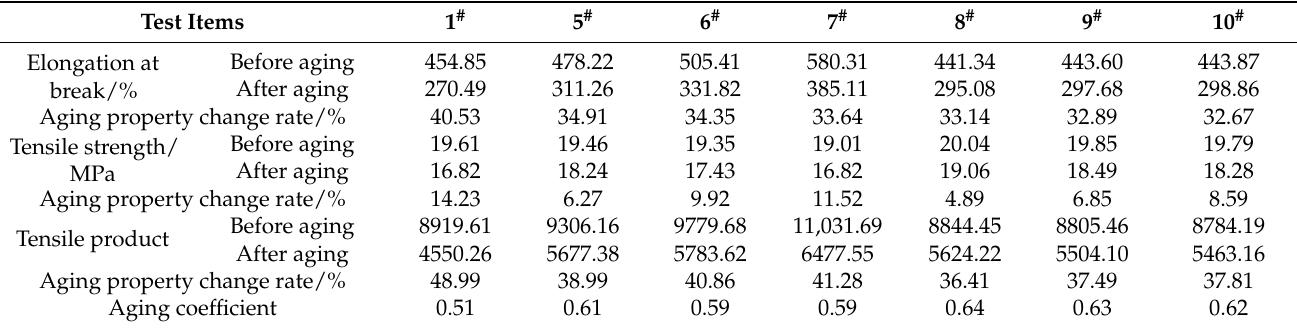
Table 8. Aging tensile properties of rubber